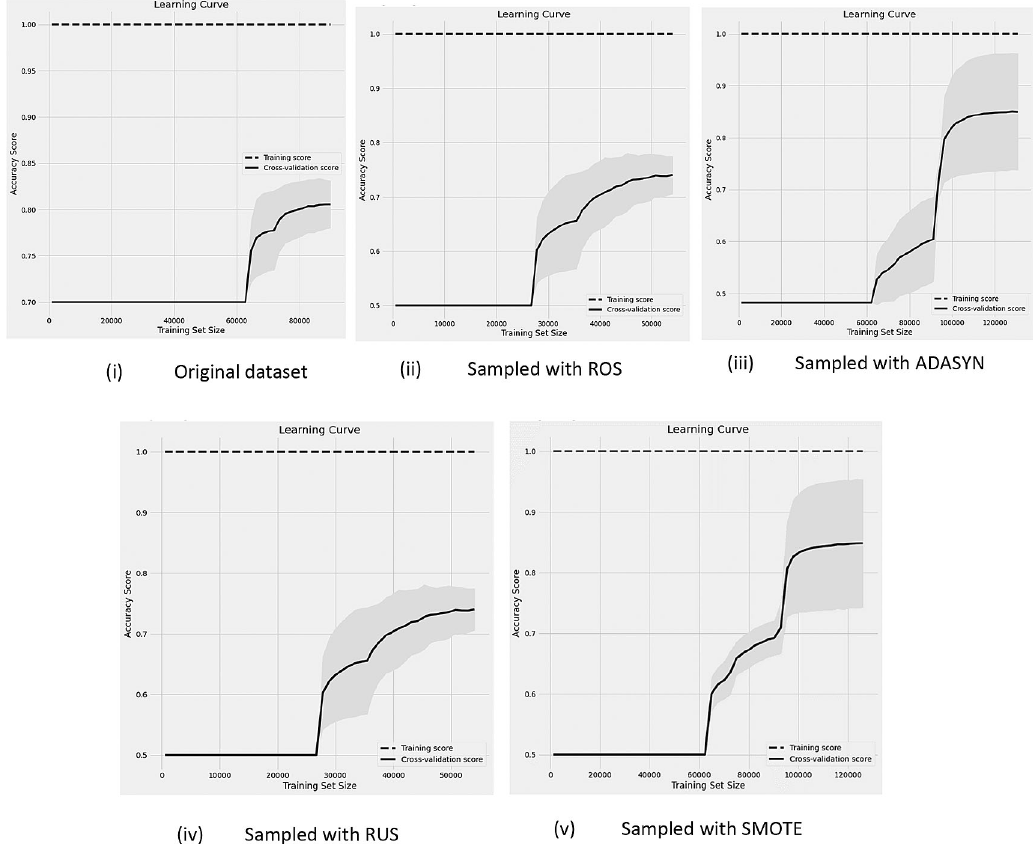
Figure4.Beforeandaftersamplingresultsoflearningcurves withthedata(70%-15%ofnon-churnand churn rate) with RF